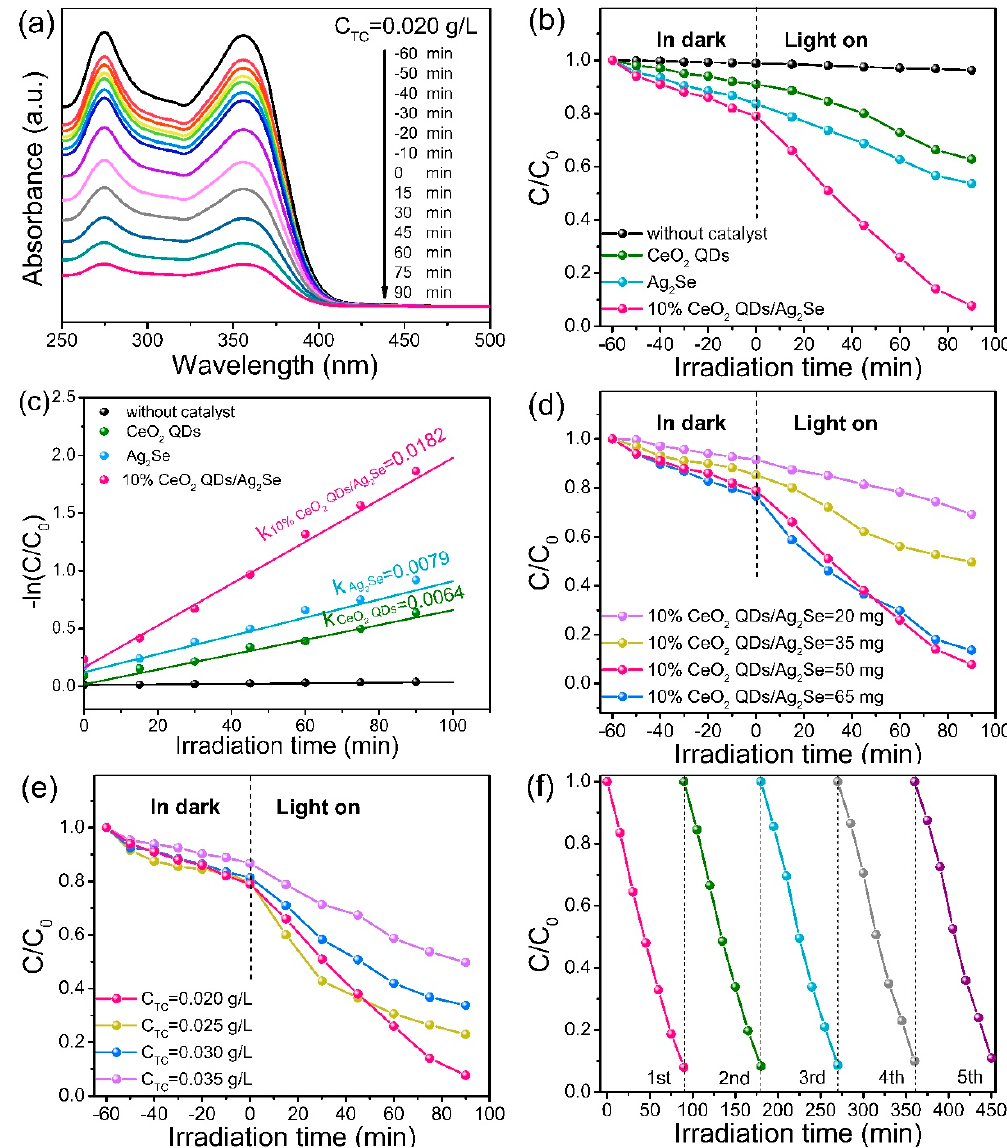
Figure 9. ( a ) Ultraviolet-visible di ff use reflectance spectra for TC photocatalytic degradation by 50 mg of 10% CeO 2 QDs / Ag 2 Se, ( b ) photodegradation curves of TC, ( c ) Kinetics plots, ( d ) e ff ect of photocatalyst concentrations on TC degradation by 10% CeO 2 QDs / Ag 2 Se, ( e ) e ff ect of initial concentration of TC on the photocatalysis, and ( f ) cycling tests on photodegradation of TC by 10% CeO 2 QDs / Ag 2 Se under visible